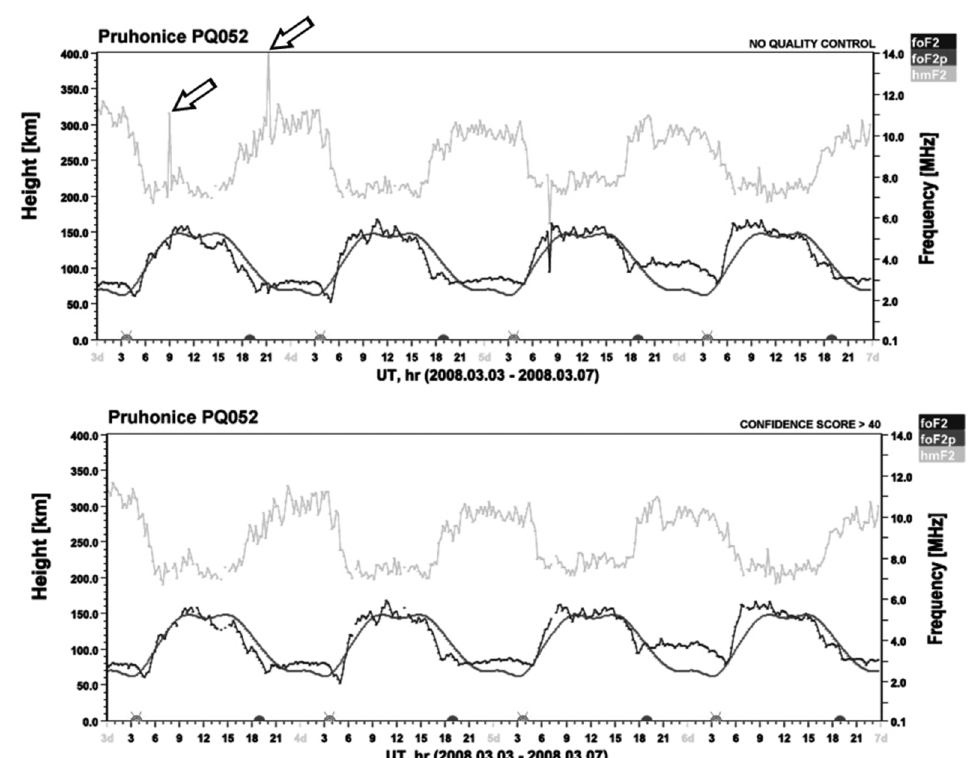
Fig. 9. ARTIST-5 autoscaling results of Pruhonice Digisonde data for 3-7 March